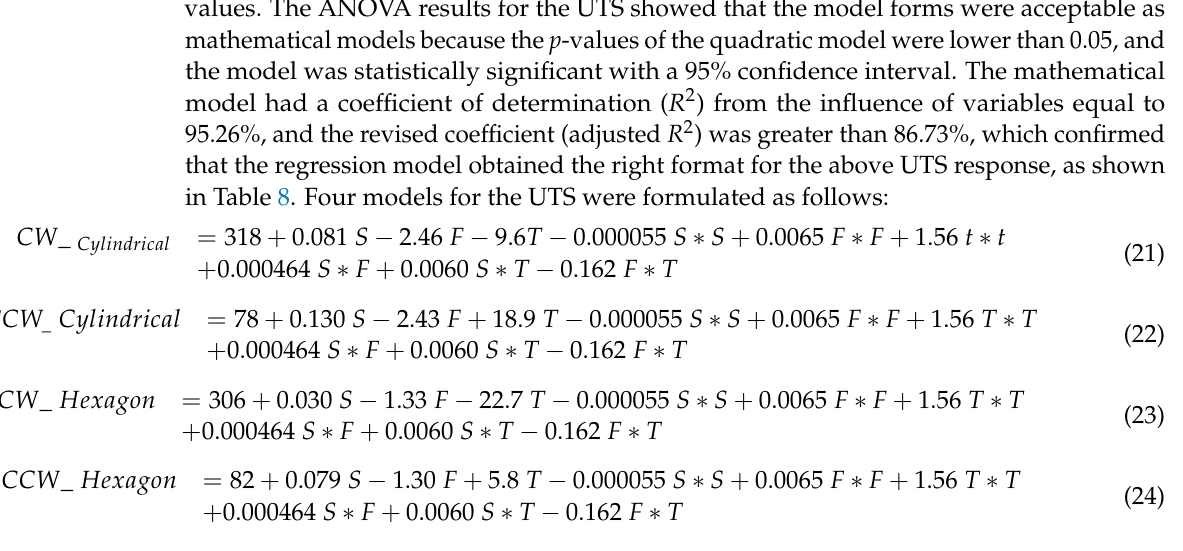
Table 8. The ANOVA results for the tensile strength response using the Design-Expert software. Source of Sum of